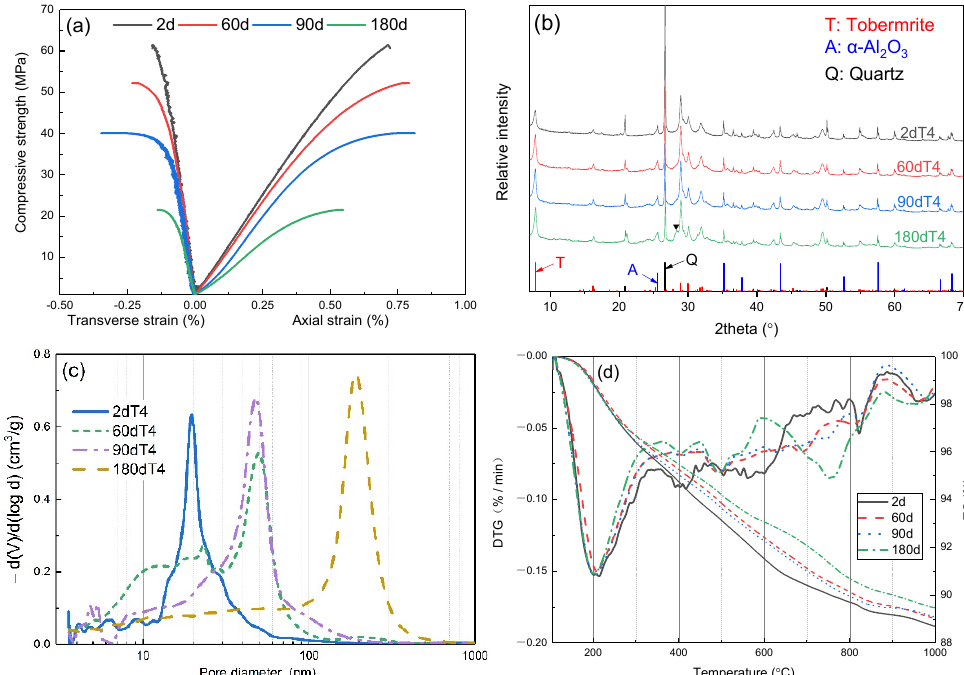
Figure 3. Relationship between macroscopic properties and microscopic properties of slurry T4 cured under 200 °C and 50 MPa from 2 to 180 d. ( a ) Stress–strain response showed decreasing resistance to load; ( b ) XRD test showed possible C-S-H structural change; ( c ) MIP test showed increasing pore diameter; ( d ) TG test showed decreasing bound water content measured between 200 and 650 °C.